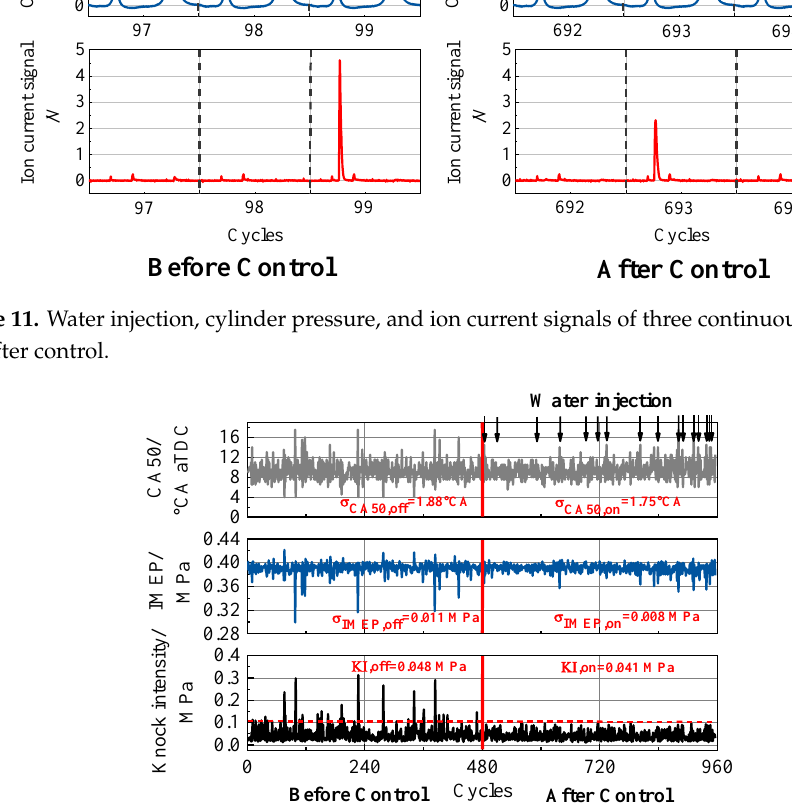
Figure 12. The variation of CA50, IMEP, and knock intensity before and after control.